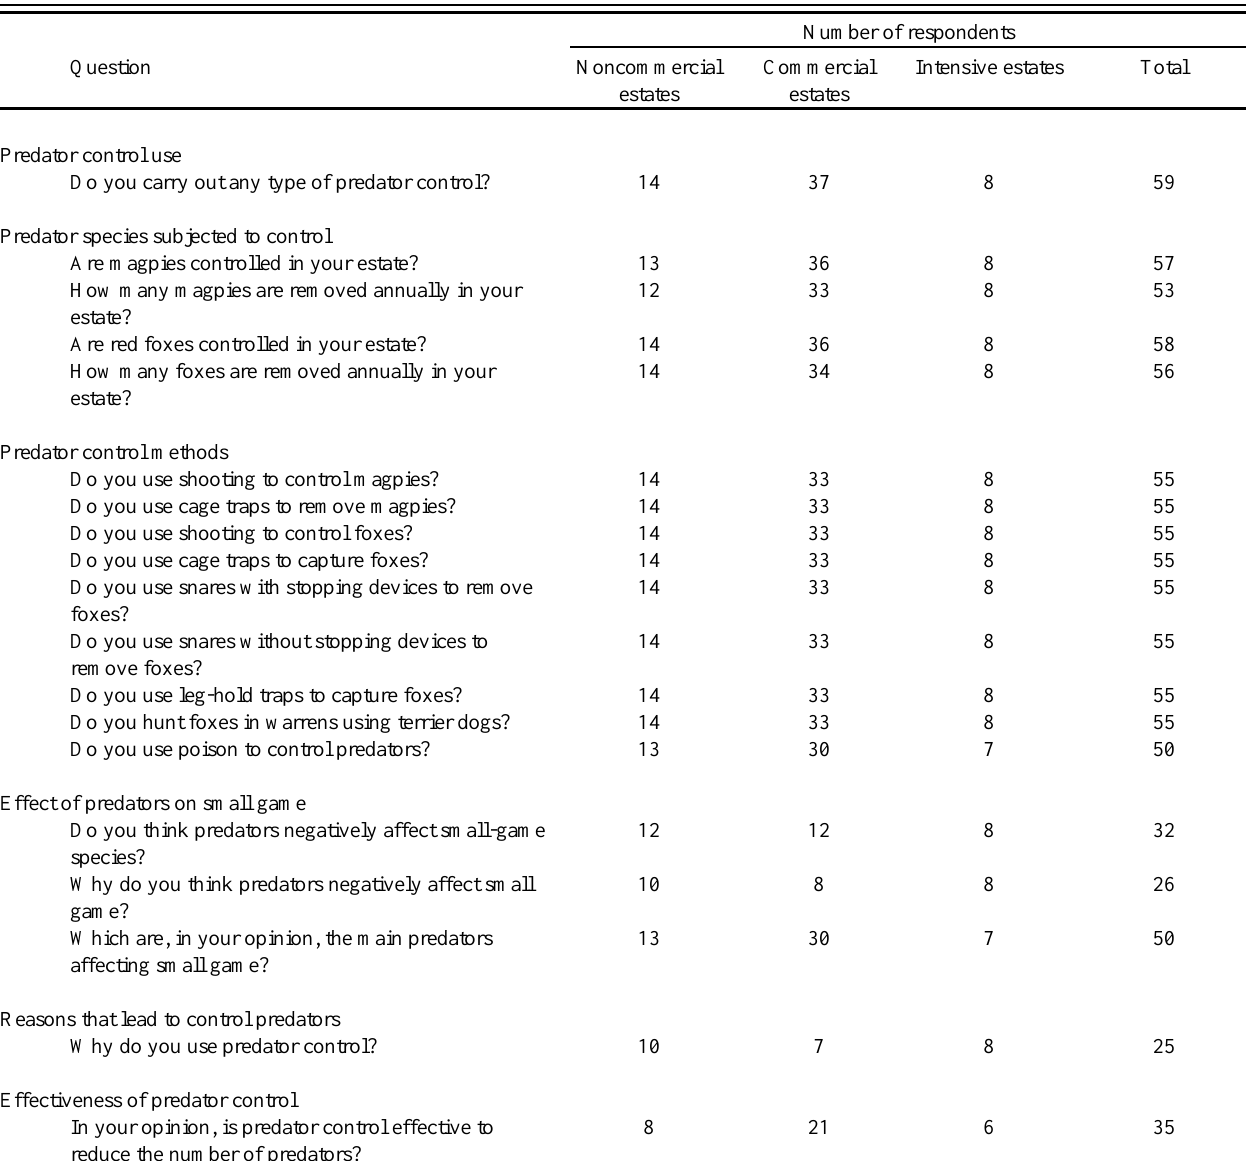
Table 1 . Themes covered in the interview and the specific questions asked to game managers. The number of respondents for each specific question in noncommercial, commercial, and intensive hunting estates is